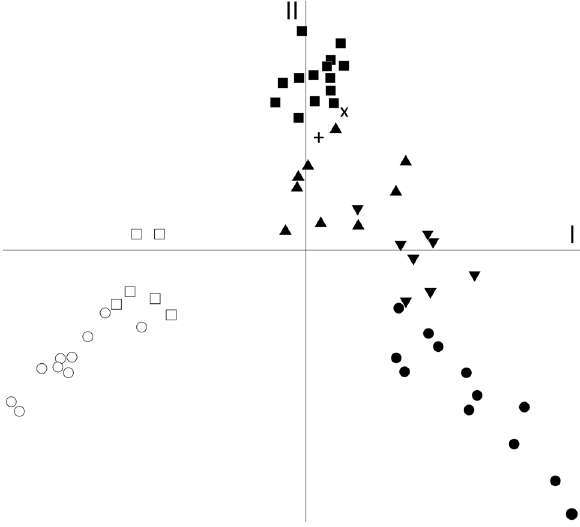
Figure 7. PCA of relevés of meadows from NE Italy lowlands (First Component: 14.8 % of total variance, second Component: 11.6 % of total variance). Relevés are labelled as in the dendro- gram of Fig.